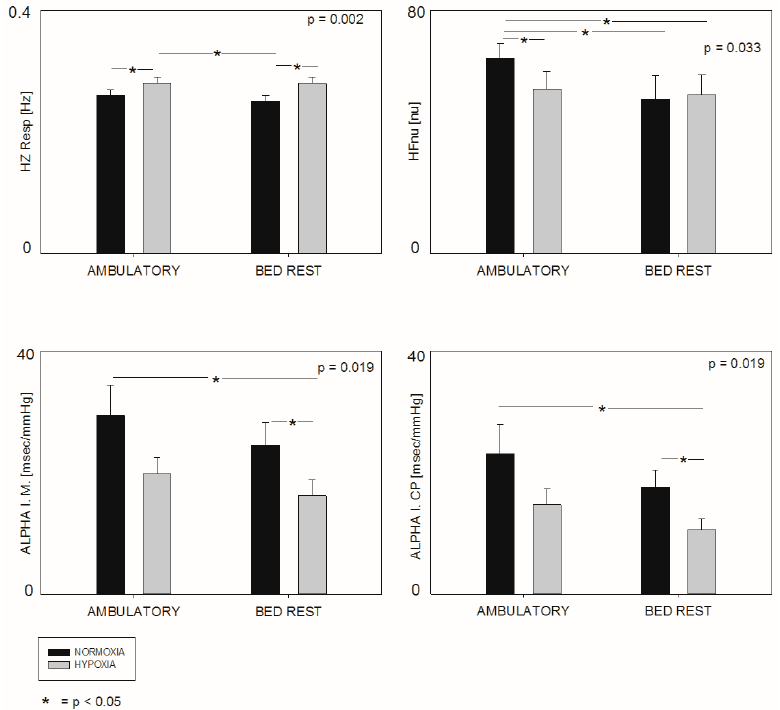
Figure 1. Significant differences in the cardiac autonomic regulation indexes among the four Figure 1. Signi fi cant di ff erences in the cardiac autonomic regulation indexes among the four cam- paigns.